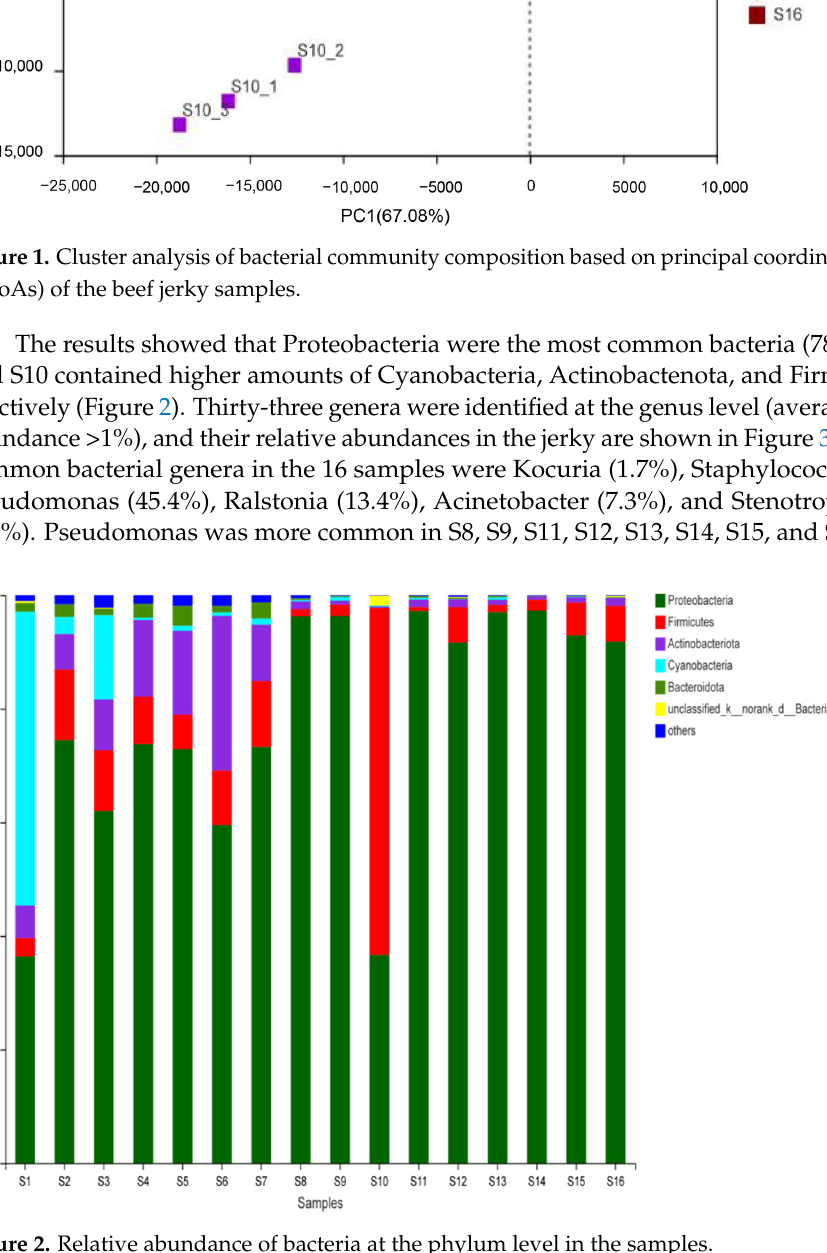
Figure 3. Relative abundance of bacteria at the genus level in the samples. 3.2. Composition of Volatile Flavor Compounds of Beef Jerky from Different Areas of Inner Mon- golia The taste and quality of beef jerky are primarily determined by its flavor profile. The results of the principal component analysis of the volatile components in our samples are shown in Figure 4. Principal components 1 and 2 differed significantly among the sample groups. Table S1 lists the concentrations of volatile compounds found in the beef jerky samples. In total, 59 volatile compounds, including 14 alcohols, 12 aldehydes, 7 esters, 6